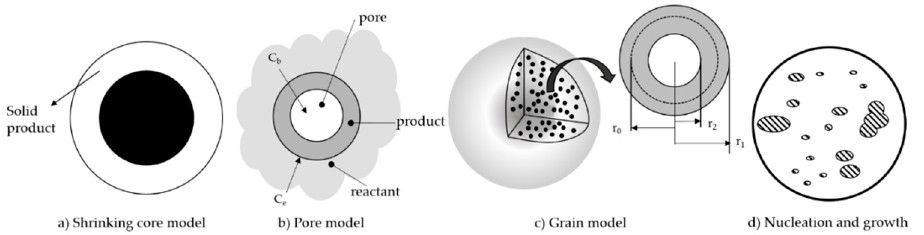
Figure 11. Solid gas reaction models: ( a ) Shrinking core model; ( b ) Pore model; ( c ) Grain model; ( d ) Nucleation and growth.